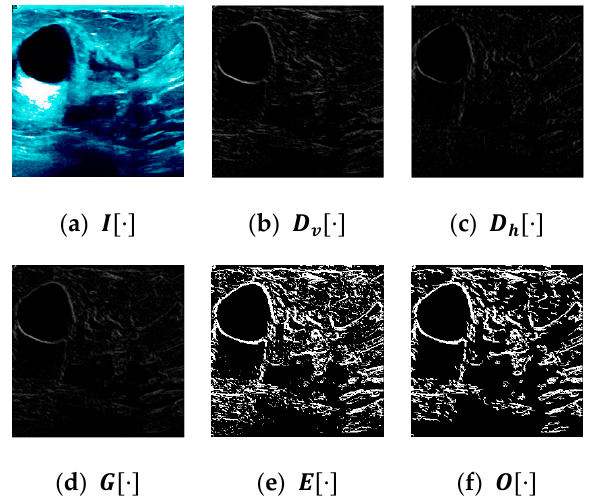
Figure 10. Breast ultrasound image edge detection and noise removal. Figure 10e is an image calculated through the contour detection and binarization process shown above and shows small dot-like noises. We remove the internal small dot-like noises through the labeling algorithm, as shown in Algorithm 2.